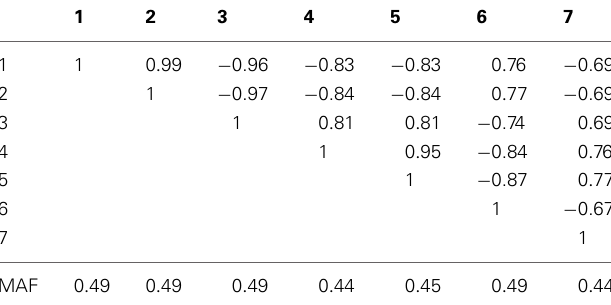
Table 1A | Linkage disequilibrium between SNPs measured by Pearson’s correlation coefficient along with the SNP minor allele frequencies in an eight marker LD block on chromosome 10, simulated based on genome scans of samples from the Lung Health Study.